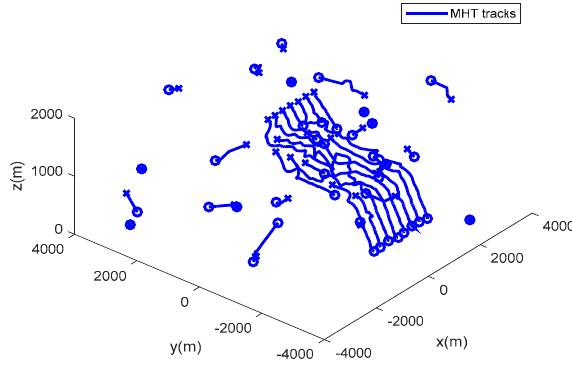
Figure 13. The OSPA distance of two algorithms in scenario 2. Figure 14. The cardinality estimation of two algorithms in scenario 2. Table 3 displays the tracking performance of the MHT-MDC and the MHT in the association quality and average processing time. We can conclude that the MHT-MDC achieves higher track continuity and data association accuracy, as it has a higher